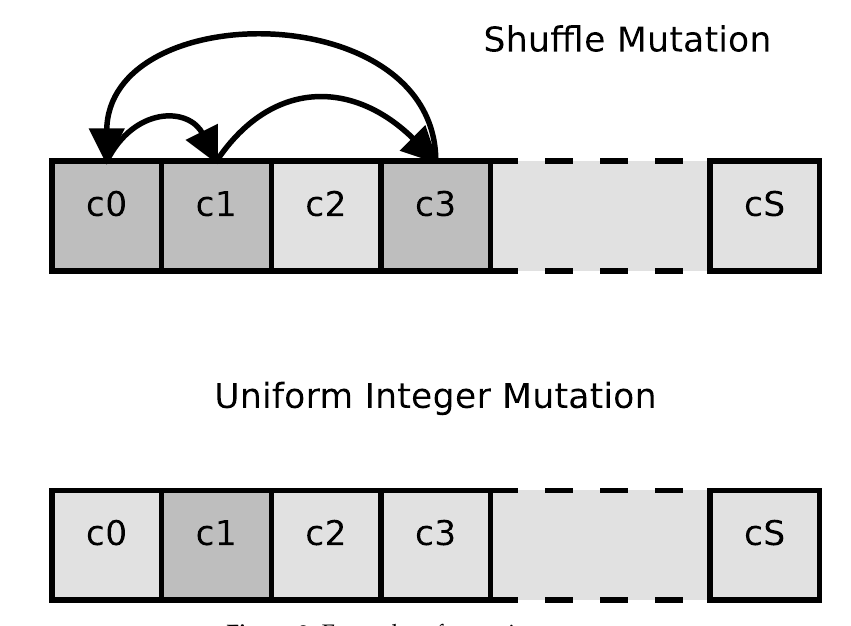
Figure 2. Examples of mutation